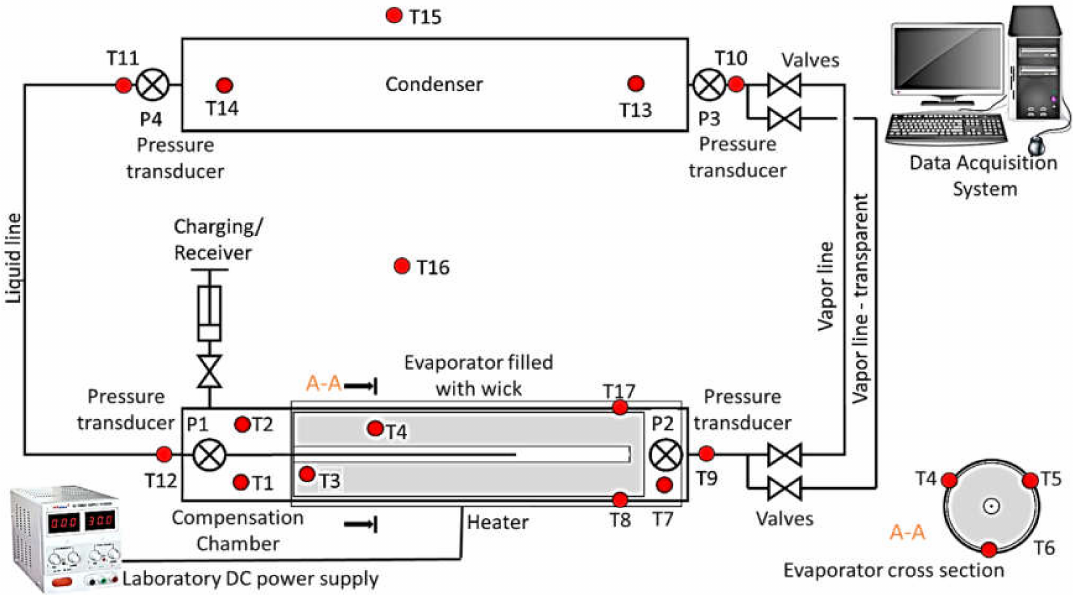
Figure 8. General schematic of LHP experimental rig with an indication of the measurement points.